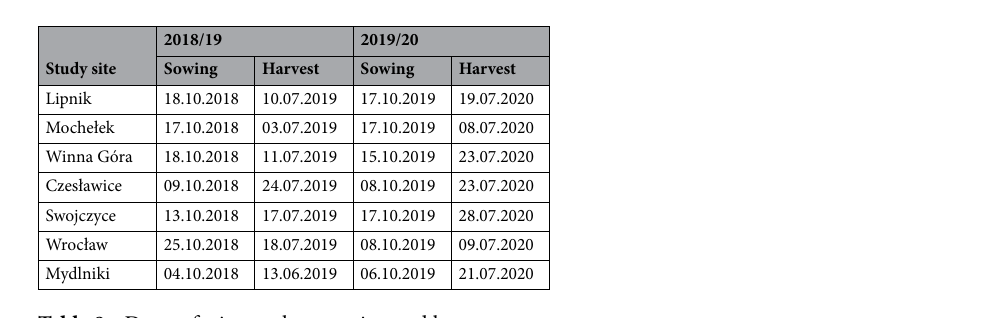
Table 8. Dates of winter wheat sowing and